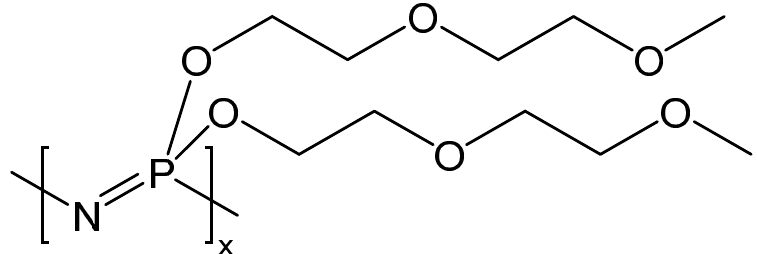
Figure 1. Chemical structure of MEEP.